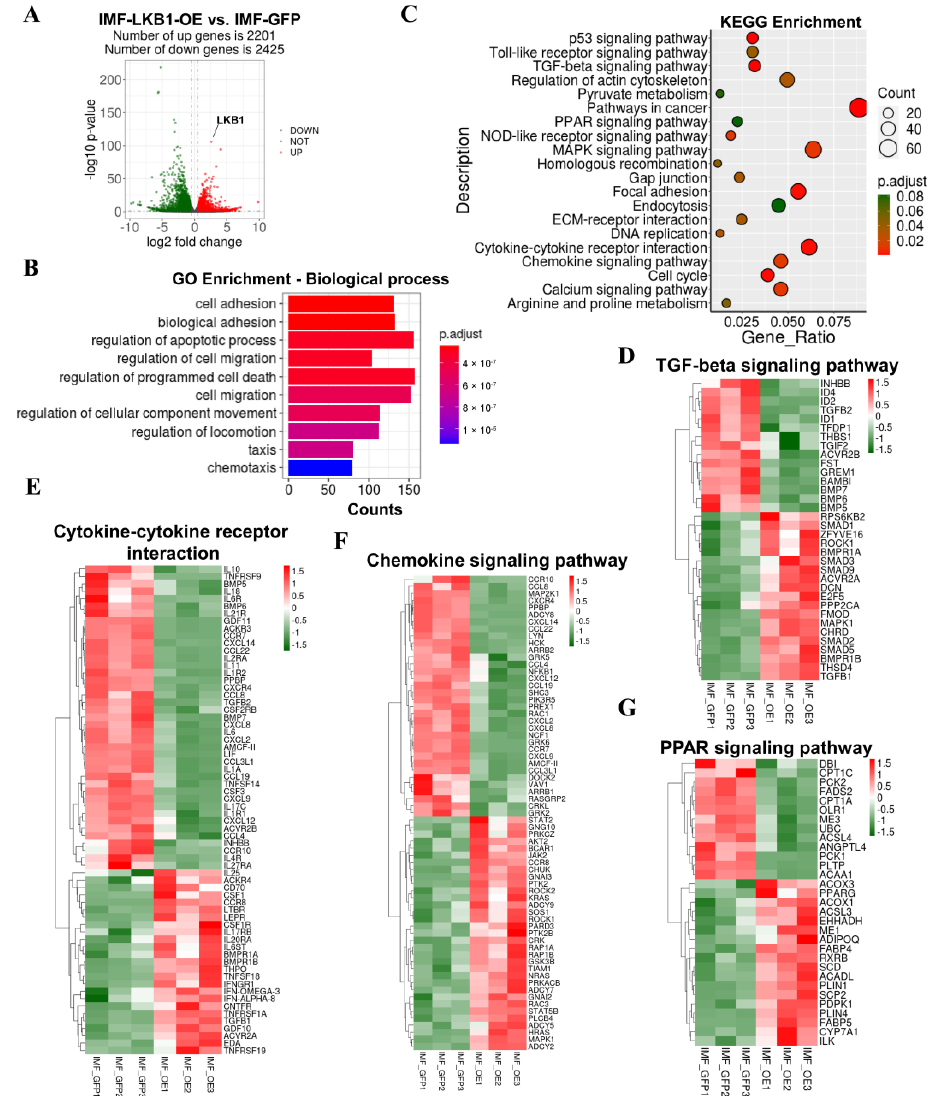
Figure 3. LKB1 overexpression alters the transcriptional profile of IMF adipocytes. ( A ) Log2 (fold change) values in exons of RNA-seq gene bodies in LKB1-overexpressing IMF adipocytes versus controls and the corresponding significance values displayed as -log10 ( p -value). The transverse and vertical dotted lines indicate the cutoff value for differential expression ( p < 0.05 and Abs (log2 (fold changes)) > 0.5). In total, 2201 and 2425 genes were identified that had induced (red) or repressed (green) expression levels by cold exposure. ( B ) Gene ontology (GO) enrichment analysis based on biological processes and enriched terms were visualized by bar plot. The bar color indicates significance, and the corresponding significance values are displayed as P.adjust. The bar length indicates significantly changed gene counts of genes involved in certain categories. ( C ) Functional enrichment analyses using Kyoto Encyclopedia of Genes and Genomes (KEGG) pathways. The triangle size indicates gene counts. The dot color indicates significance, and the corresponding significance values are displayed as P.adjust. ( D – G ) Heatmap of TPM expression values of genes involved in cytokine–cytokine receptor interaction ( D ), chemokine signaling pathway ( E ), TGF-beta signaling pathway ( F ), and PPAR signaling pathway ( G ). Only genes with p < 0.05 are displayed.